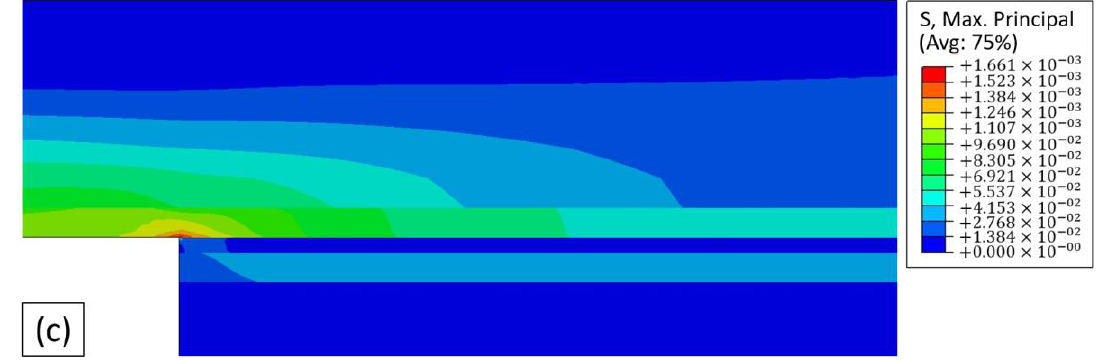
Figure 7. Maximum principal stress distribution for: ( a ) CFRP, ( b ) Al-CFRP-Al, and ( c ) CFRP-Al.